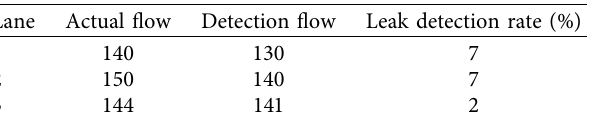
Table 5: Test results at 7 o’clock in the evening using the pure video detection mode.